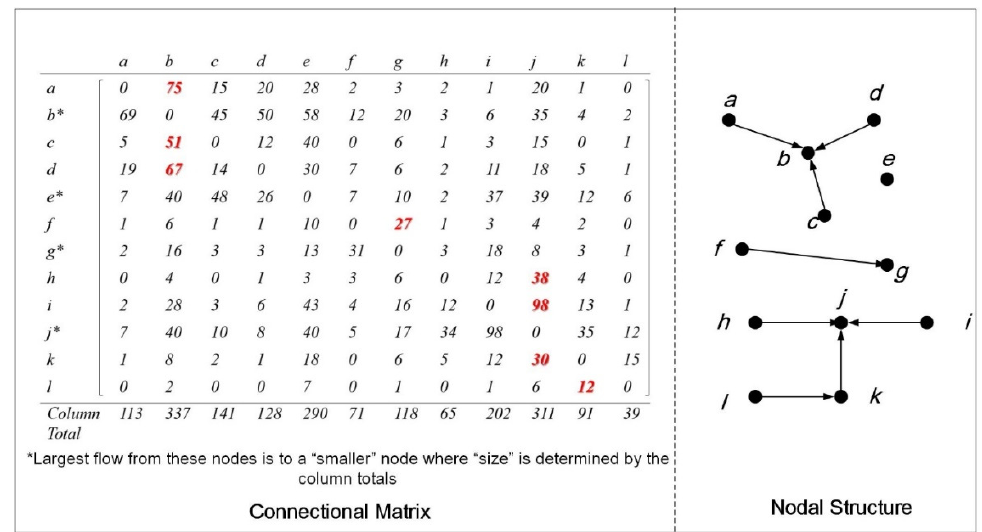
Figure 3. Network structure in primary linkage analysis (PLA). The red of the number represents the largest flow of a “smaller” node. Source: Adapted from Nystuen et al. [49].